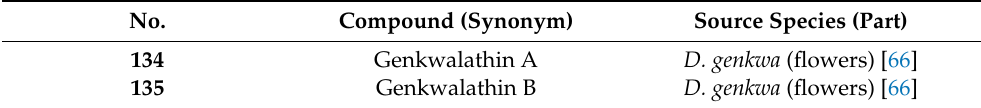
Table 8. Structures and sources of lathyrane-type diterpenoids ( 134 – 135